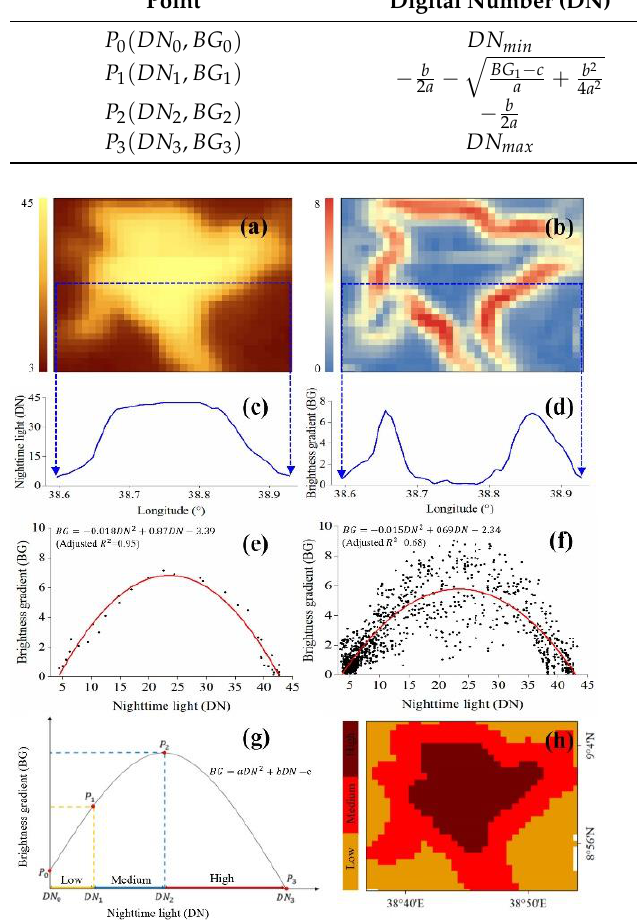
Figure 3. ( a ) Defense Meteorological Satellite Program’s Operational Line-scan System (DMSP/OLS) nighttime light and ( b ) brightness gradient in 2013 for Addis Ababa city; ( c ) and ( d ) show the latitudinal transect of the pixel-level nighttime light and brightness gradient across Addis Ababa city, respectively; ( e ) and ( f ) the quadratic regression relationship between nighttime light and brightness gradient in 2013 for the latitudinal transect and Addis Ababa city; ( g ) schematic diagram of the relationship between nighttime light and brightness gradient and the subdivision based on the Equation (8); ( h ) results of partitioning for Addis Ababa city.